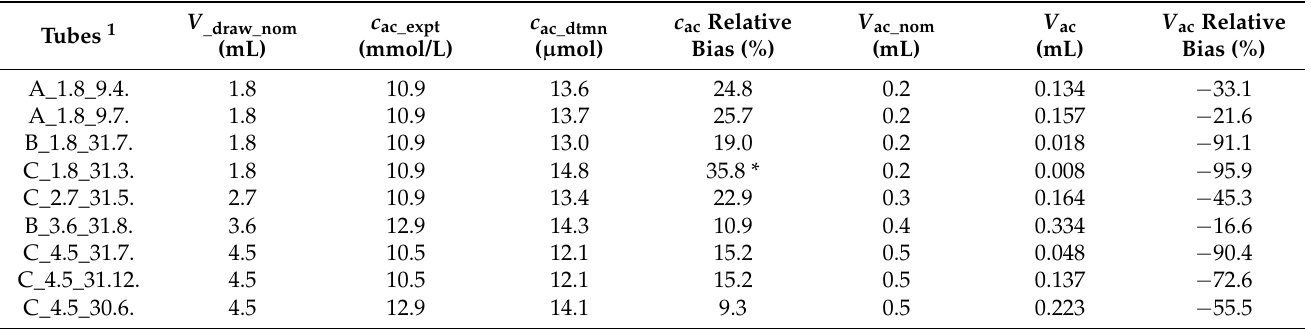
Table 6. Results of citrate determination ( c ac_dtmn ) after Milli-Q water addition into blood